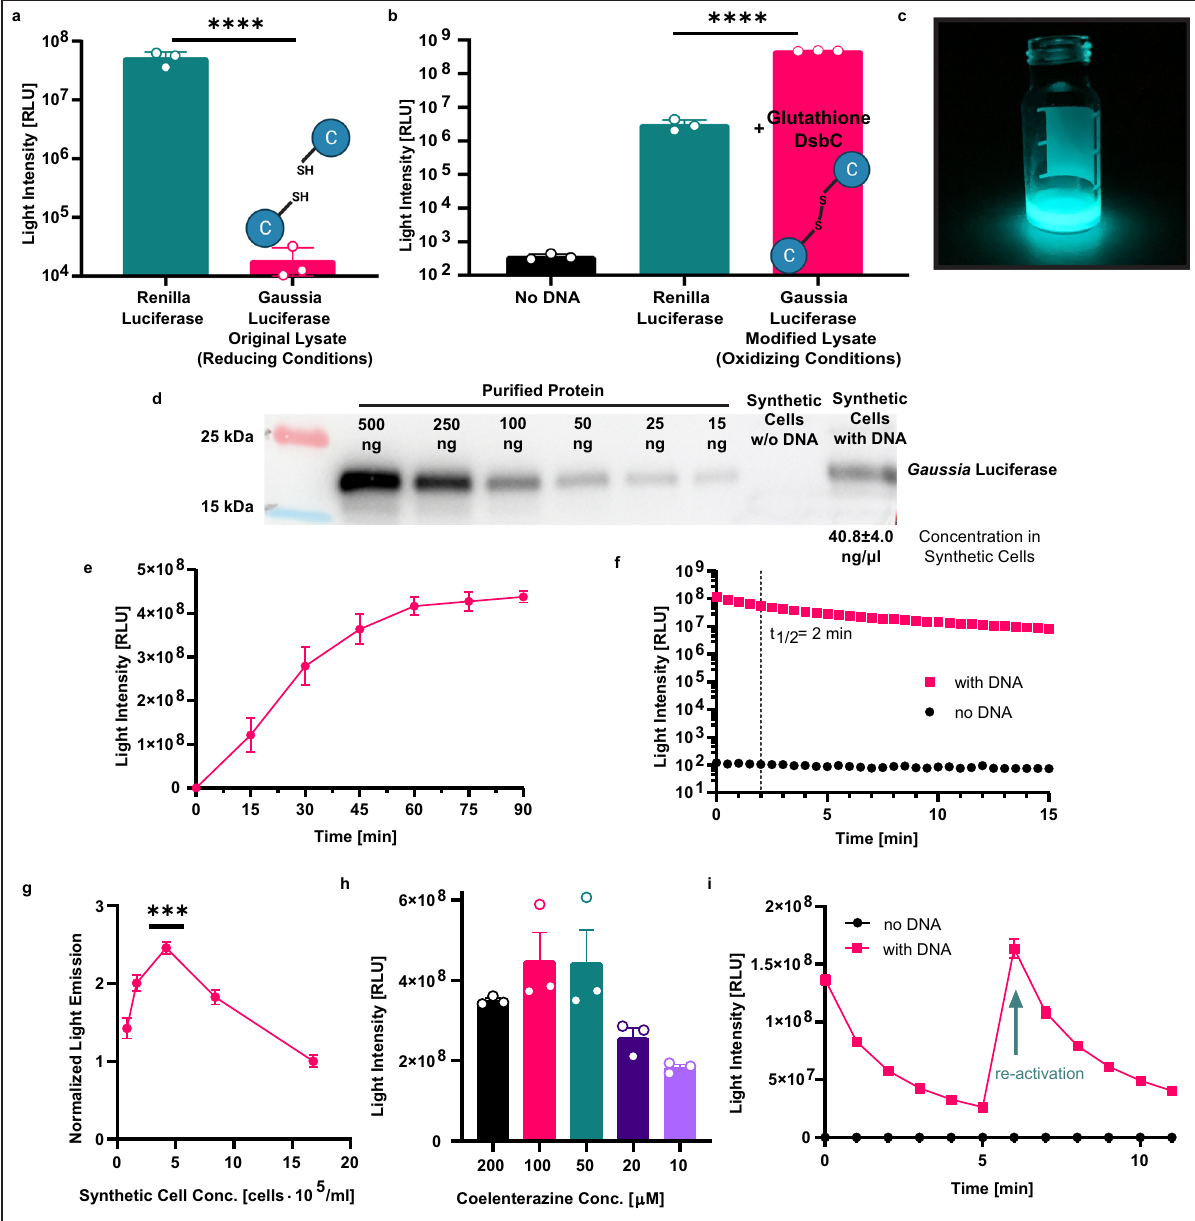
Fig. 2 Engineering light-generating synthetic cells. a Comparison of light emission in cell-free protein synthesis reactions expressing Renilla Luciferase (Rluc) or Gaussia luciferase (Gluc) using unmodi fi ed lysate (with reducing conditions). Nested two-tailed t -test P value; ****p = 3.82 × 10 -6 . b Light emission by Gluc-expressing synthetic cells containing lysate modi fi ed with glutathione and disul fi de bond isomerase C (DsbC) to produce an oxidizing environment, compared to light emission by Rluc-expressing synthetic cells. Nested one-way ANOVA with multiple comparisons test adjusted P value; ****p = 6.6×10 -14 . c Light emission from a Gluc-expressing synthetic cell solution. d Western blot quanti fi cation of Gluc production in synthetic cells. Gaussia luciferase concentration in synthetic cells is calculated based on n = 2 independent experiments. e Gluc production kinetics in synthetic cells at 37 °C. f Kinetics of the Gluc enzymatic reaction in synthetic cells after one addition of 100 µ M coelenterazine. g Light emission from Gluc-expressing synthetic cells diluted to different concentrations after incubation. Nested one-way ANOVA with multiple comparisons test adjusted P -values; ****p = 8.3×10 -7 , ***p = 0.00062, ****p = 3.7×10 -5 , ****p = 1.3×10 -8 , for comparisons of 4.2×10 5 synthetic cells ml -1 to 0.8×10 5 , 1.7×10 5 , 8.4×10 5 , and 16.8×10 5 synthetic cells ml -1 , respectively. h Light emission in ranging coelenterazine concentrations by Gluc-expressing synthetic cells. Data is expressed as a mean ± s.e.m. ( n = 3 independent samples). i Temporal control over light emission in Gluc-expressing synthetic cells with two timed additions of 0.125 nmol coelenterazine (second addition marked with a green arrow). for a , b , e , f , g , i . Data is expressed as a mean ± standard deviation ( n = 3 independent samples). Source data are provided as a Source Data fi